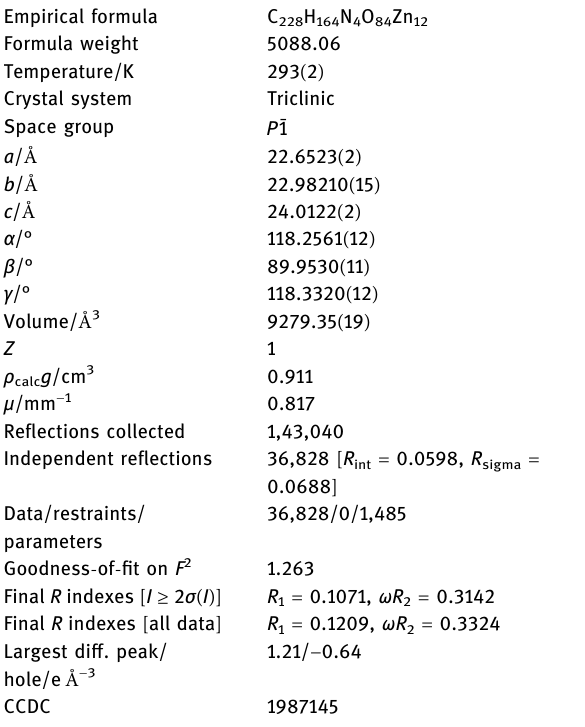
Table 1: The parameters of crystallography and the re fi nement for complex 1 Empirical